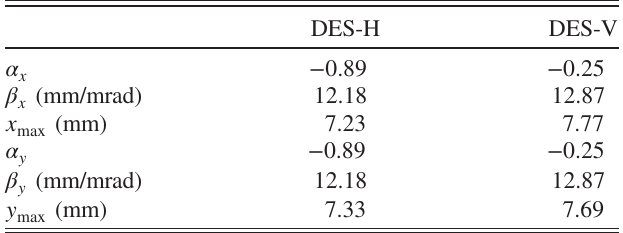
TABLE I. Main beam parameters at the start of the deflection and energy selection (DES)